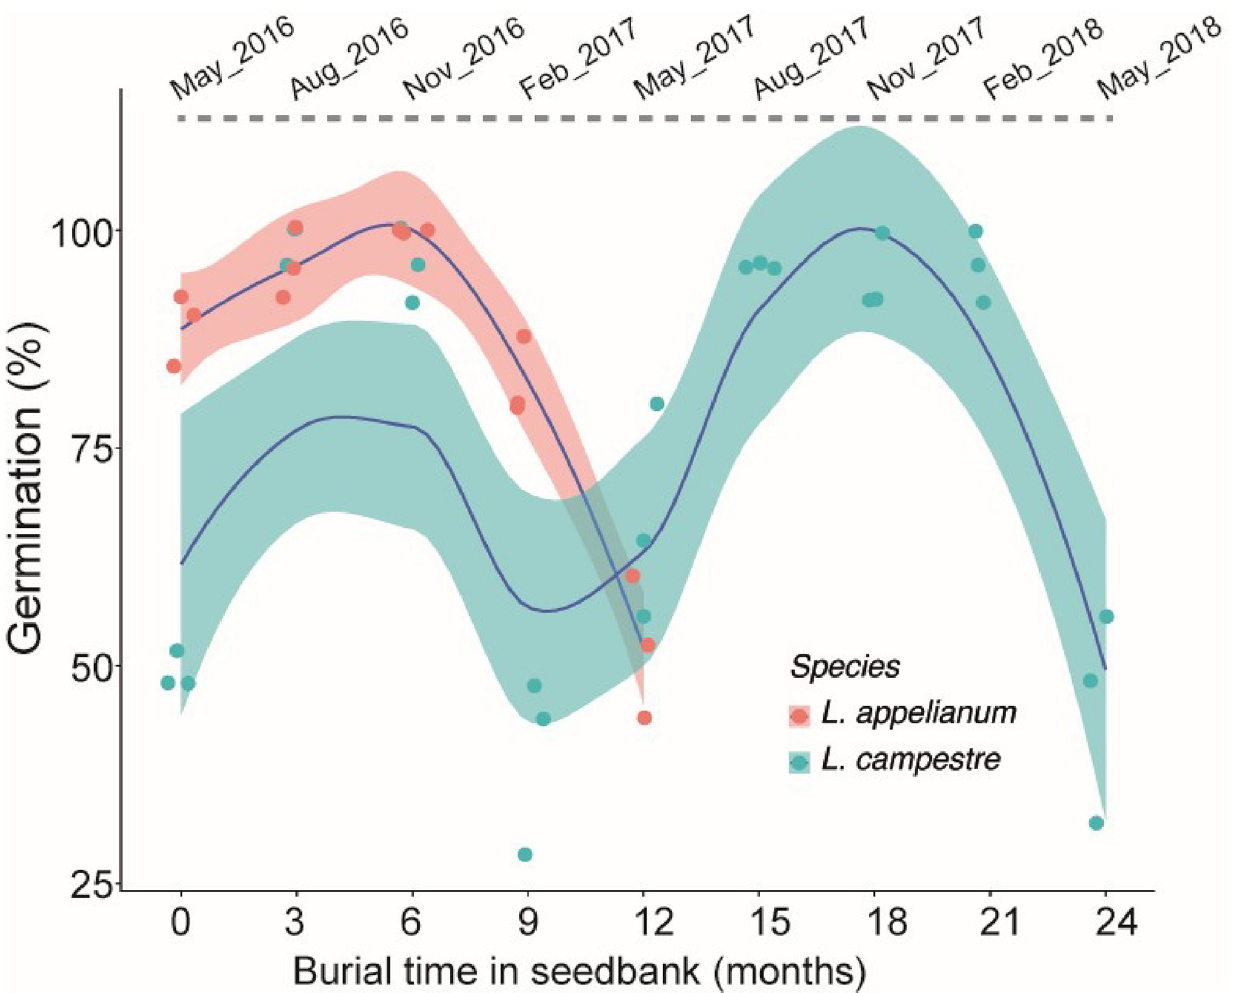
Fig 5. Distinct dormancy cycling of indehiscent L . appelianum and dehiscent L . campestre in the soil seedbank. Mean germination percentages of 75 seeds (from three randomly chosen seed bags) excavated every three months are represented as dot plots. The blue lines represent the regression over months of burial and germination with 95% confidences represented as shaded areas around the respective